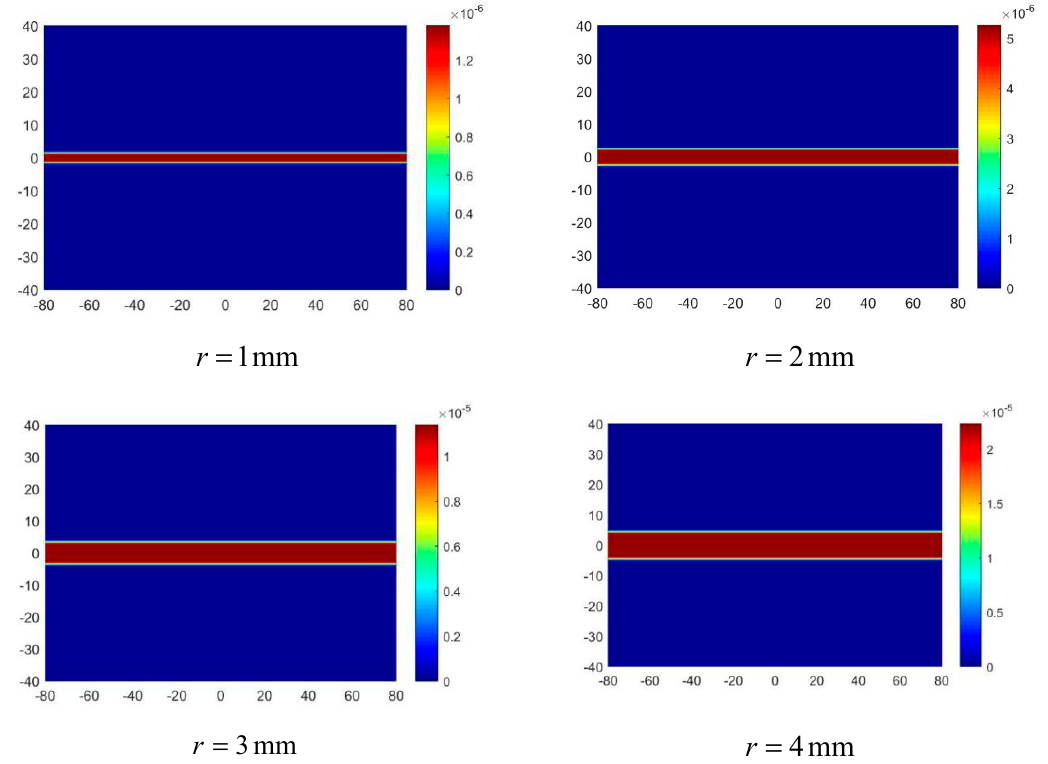
Figure 17. Imaging results of arterial blood flow profile with different r values.